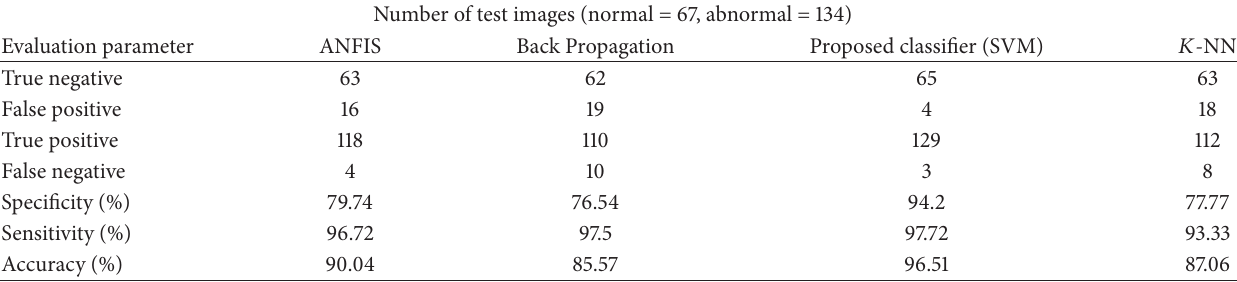
Table 7: Comparison of accuracies in different classifiers.